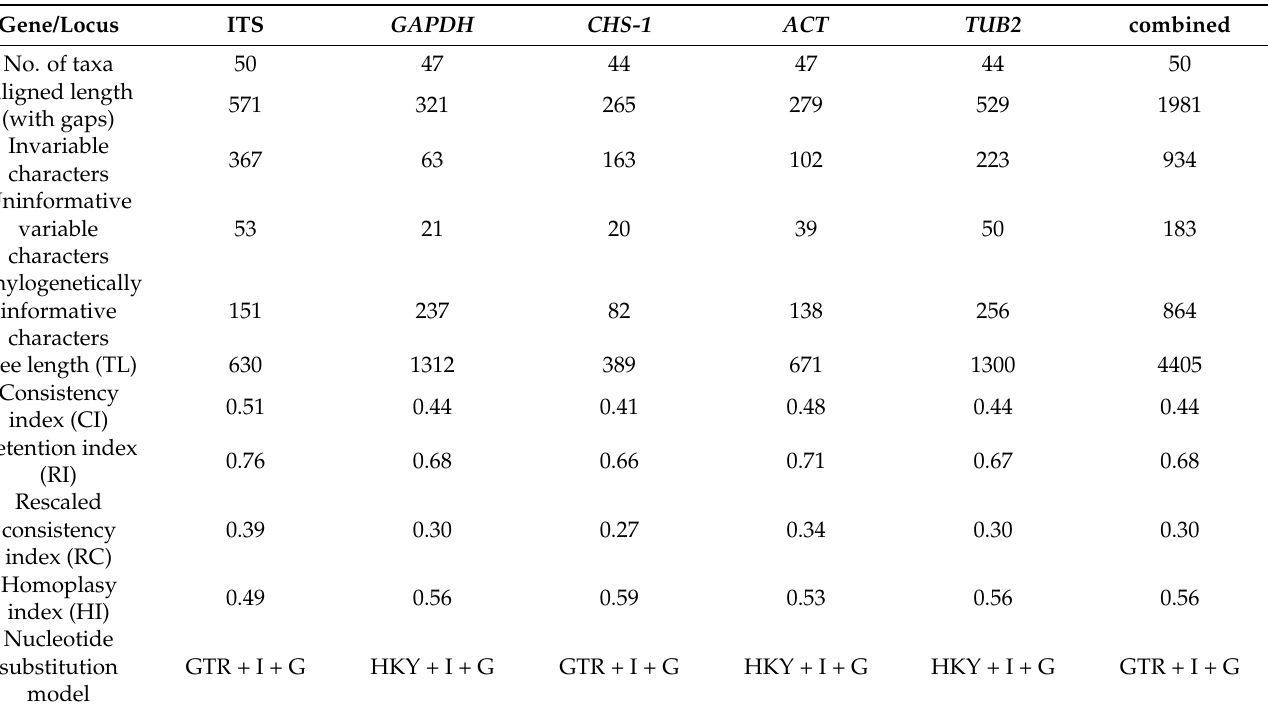
Table 5. Comparison of alignment properties in parsimony analyses of gene/locus and nucleotide substitution models used in phylogenetic analyses of C. folicola and other